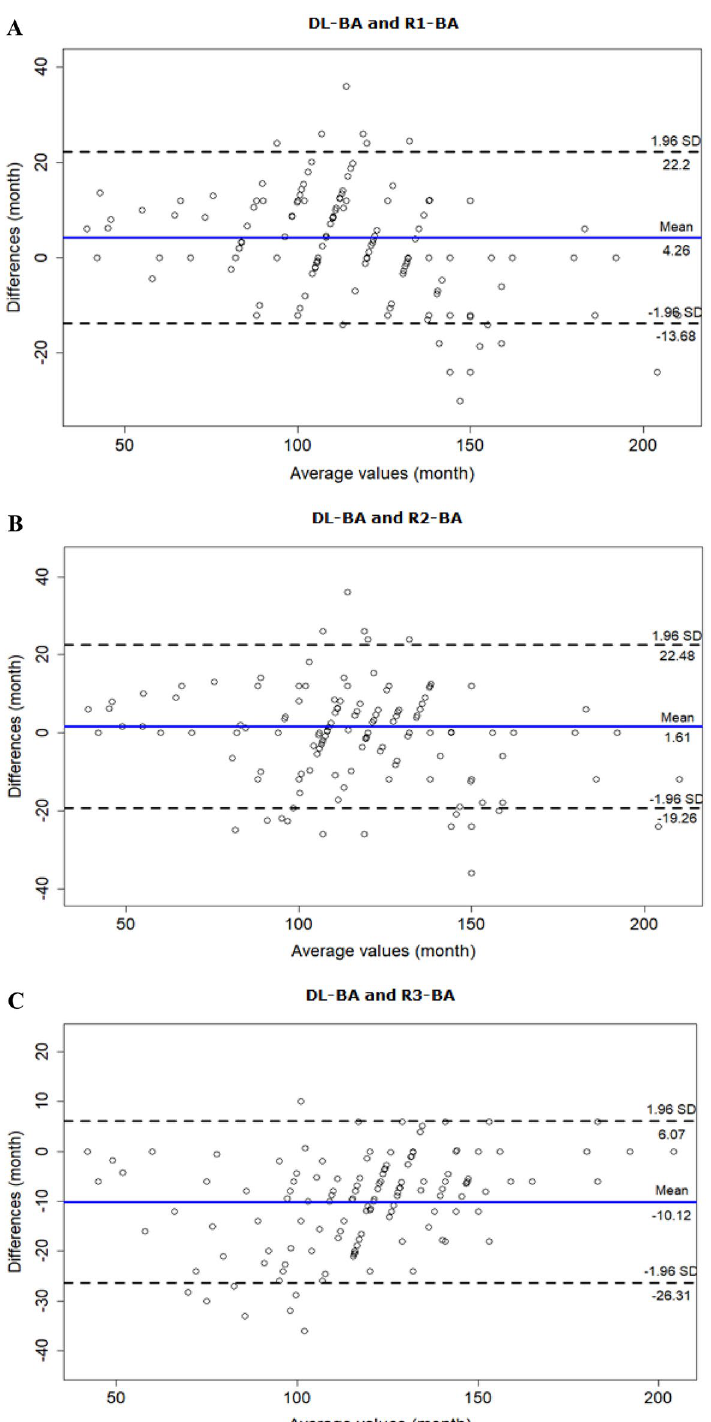
Figure 5. Bland–Altman plots for DL-estimated BA vs. each reviewer-estimated BA. ( A ) Bland–Altman plot for DL-BA and R1-BA demonstrates DL’s tendency to overestimate BA compare to R1, especially of children over the age of 110 months. ( B ) Bland–Altman plot for DL-BA and R2-BA demonstrates DL’s overall tendency to overestimate BA compare to R2. ( C ) Bland–Altman plot for DL-BA and R3-BA demonstrates R3’s tendency to overestimate BA compare to DL, especially of children below the age of 100